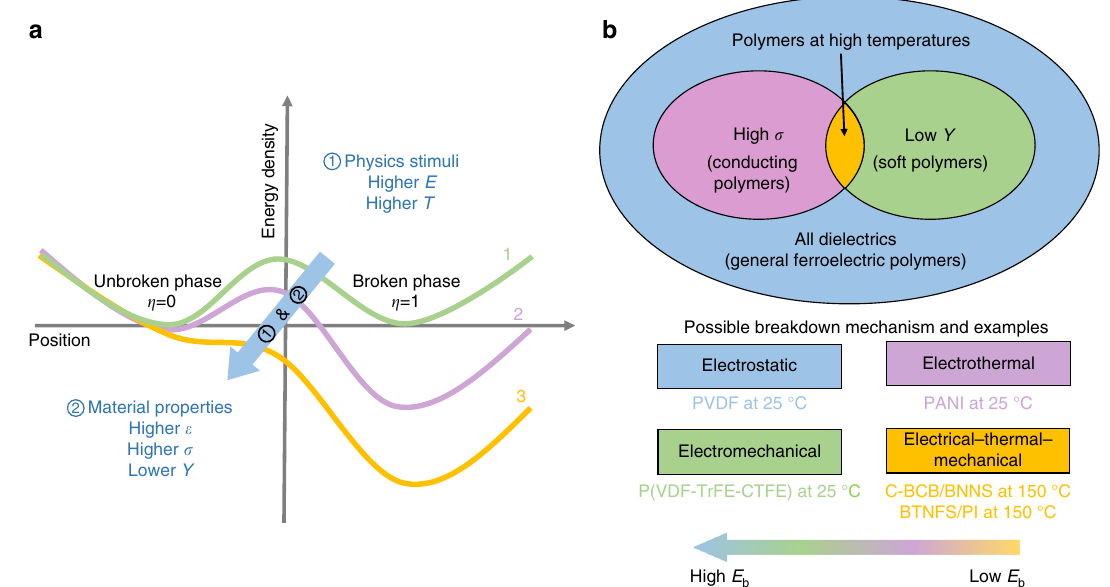
Fig. 4 Schematic diagrams for understanding and classifying breakdown mechanisms. a Variation of the energy pro fi le as function of the order parameter for polymers under physical stimuli. Each solid line denotes the double-well energy pro fi le under different stimuli. The blue arrow signi fi es that the energy pro fi le can be tilted by physics stimuli or changes of material properties. b Identi fi cation of breakdown mechanisms in polymer-based material systems. Examples of poly(vinylidene fl uoride-hexa fl uoropropylene) (PVDF), poly(vinylidene fl uoride ‐ tri fl uoroethylene ‐ chlorotri fl uoroethylene) (P(VDF-TrFE- CTFE)), polyaniline (PANI), cross-linked divinyltetramethyldisiloxanebis(benzocyclobutene) BNNS composite (C-BCB/BNNS), and BaTiO 3 nano fi ber/ polyimide (BTNFS/PI) are from experiments 23 – 27 . Different color regions represent possible breakdown mechanisms of different dielectrics. From the electrostatic breakdown (in blue) to electrical – thermal – mechanical breakdown (in yellow), the breakdown strength